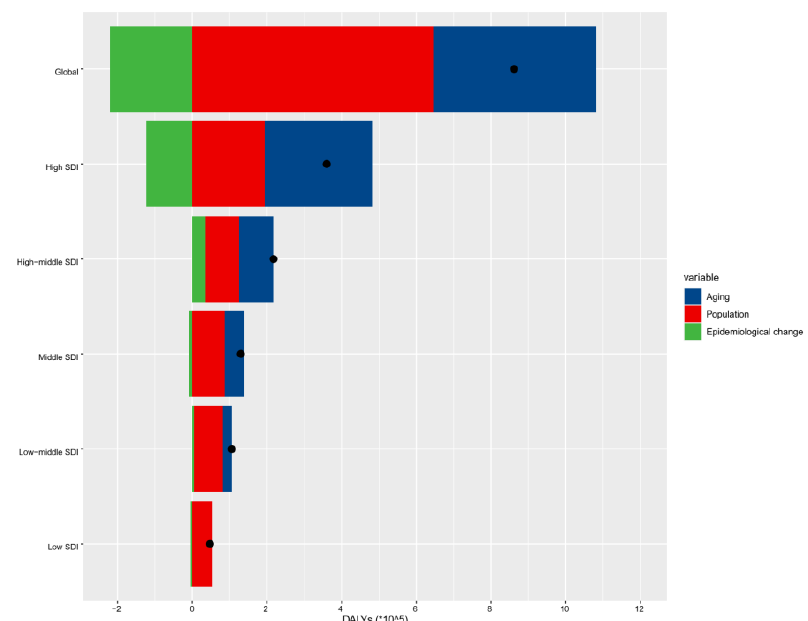
Figure 3. Changes in nrCAVD DALYs according to population-level determinants of population growth, aging, and epidemiological change from 1990 to 2019 at the global level and by SDI quintile. The black dot represents the overall value of change contributed by all three components. For each component, the magnitude of a positive value indicates a corresponding increase in nrCAVD DALYs attributed to the component, and the magnitude of a negative value indicates a corresponding decrease in nrCAVD DALYs attributed to the related component. nrCAVD, non-rheumatic calcific aortic valve disease; SDI, socio-demographic index.